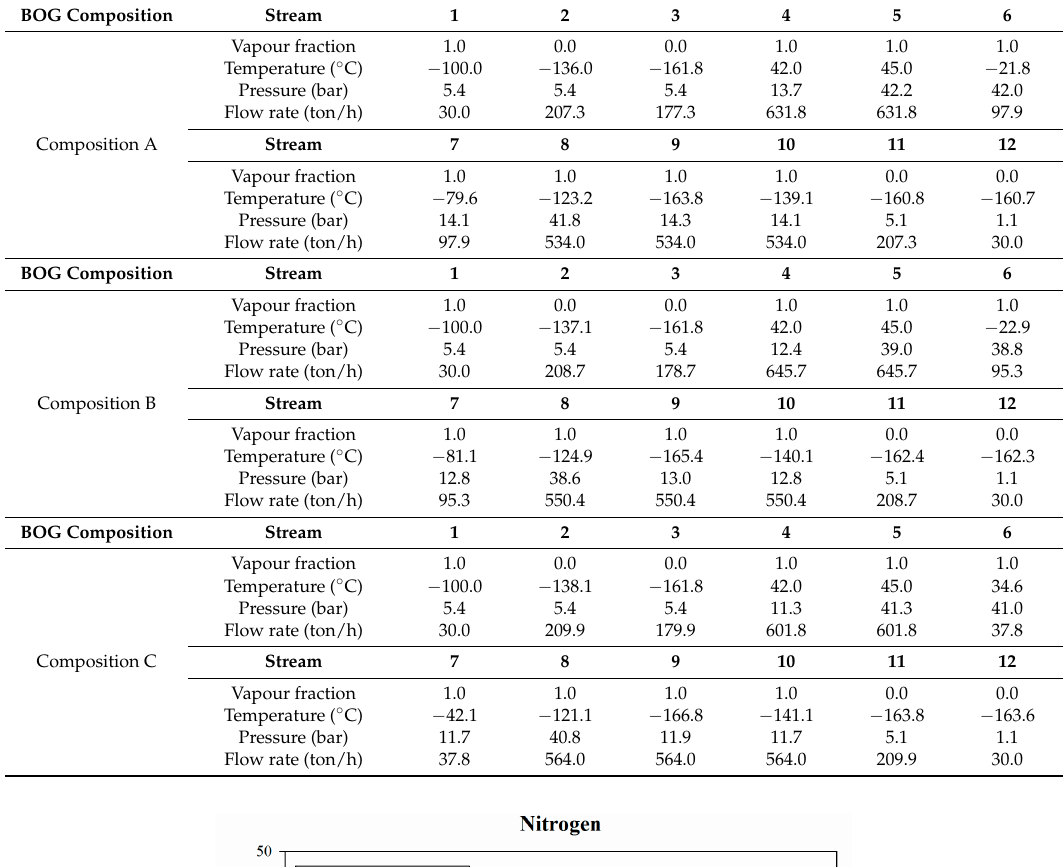
Table 6. Basic process specifications of System II.